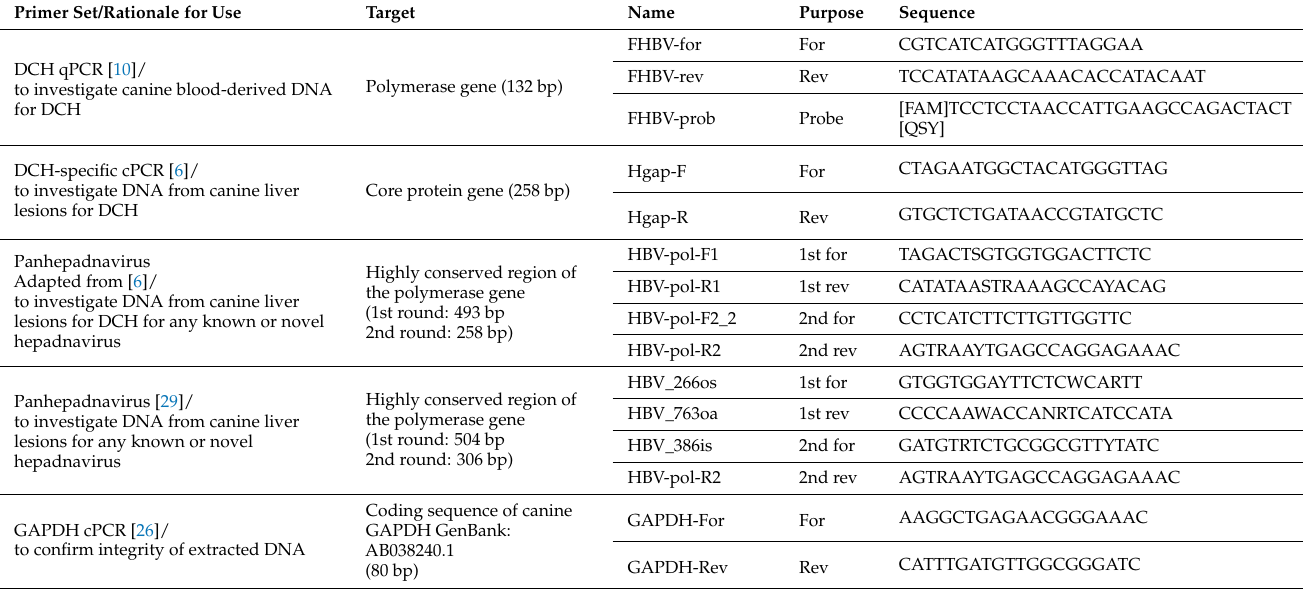
Table 1. Oligonucleotides used in this